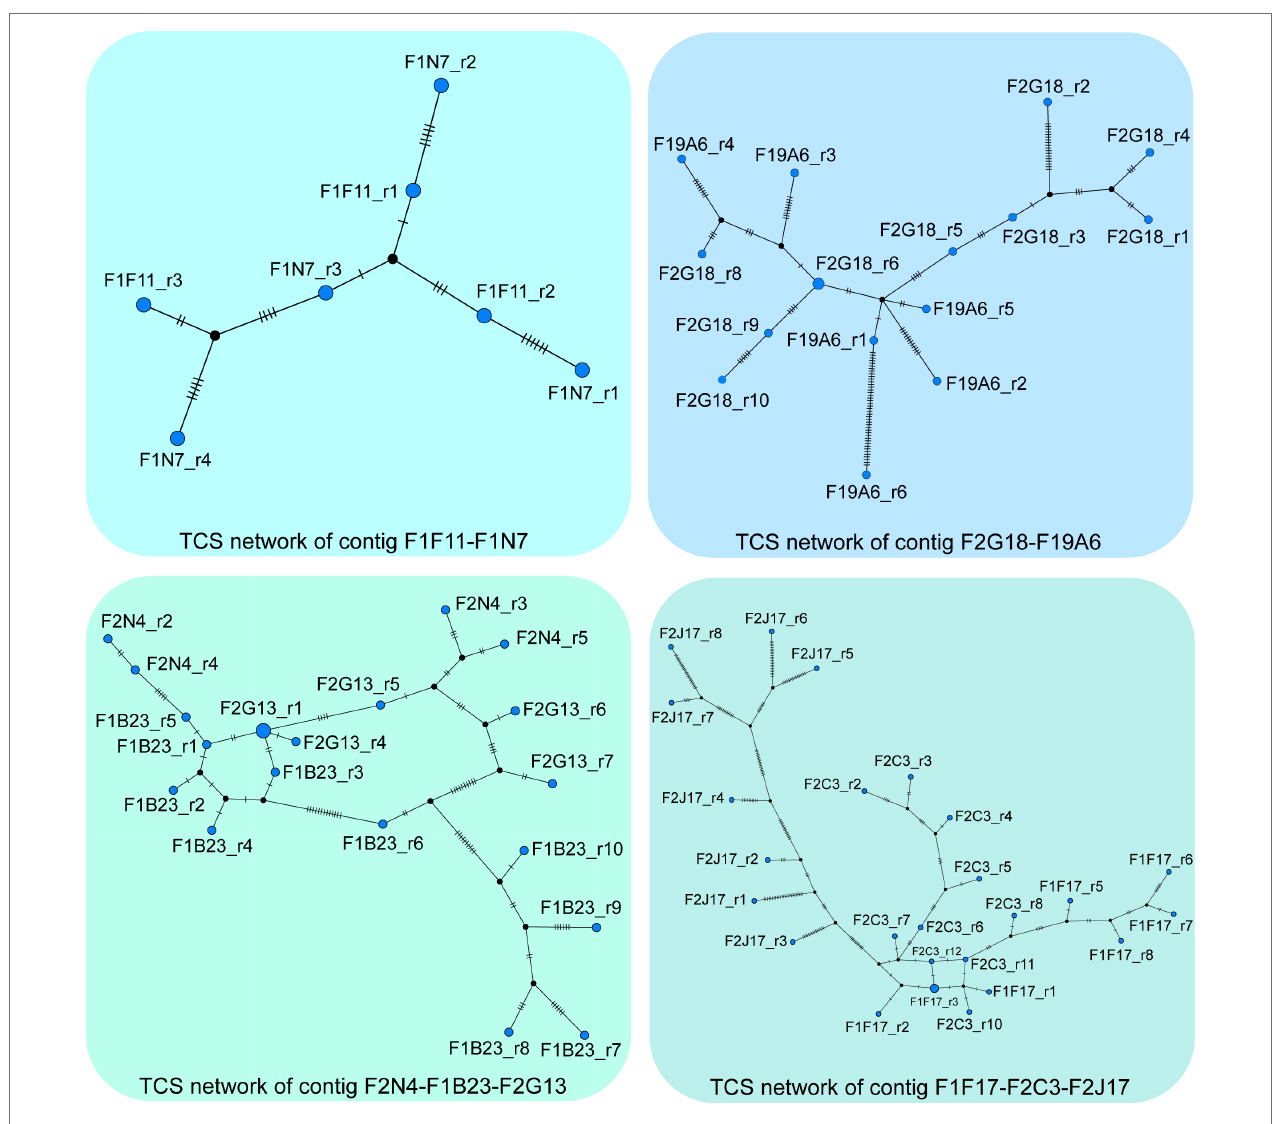
FIGURE 1 | The TCS networks were inferred from rDNA units of the contigs F2N4-F1B23-F2G13, F1F17-F2C3-F2J17, F1F11-F1N27 and F2G18-F19A6 identified in (Sims et al., 2021). The first unit of BAC F2N4 and the fourth unit of BAC F1F11 were excluded from the analysis. Furthermore, the highly repetitive Sal I boxes were not taken into account for this data analysis. In the network, each node represents a unique sequence and its size is proportional to its frequency within the data. Short vertical bars on the lines connecting similar sequences represent the number of variations between them. Visualizations of the analyses of the 59 individual BACs are available upon